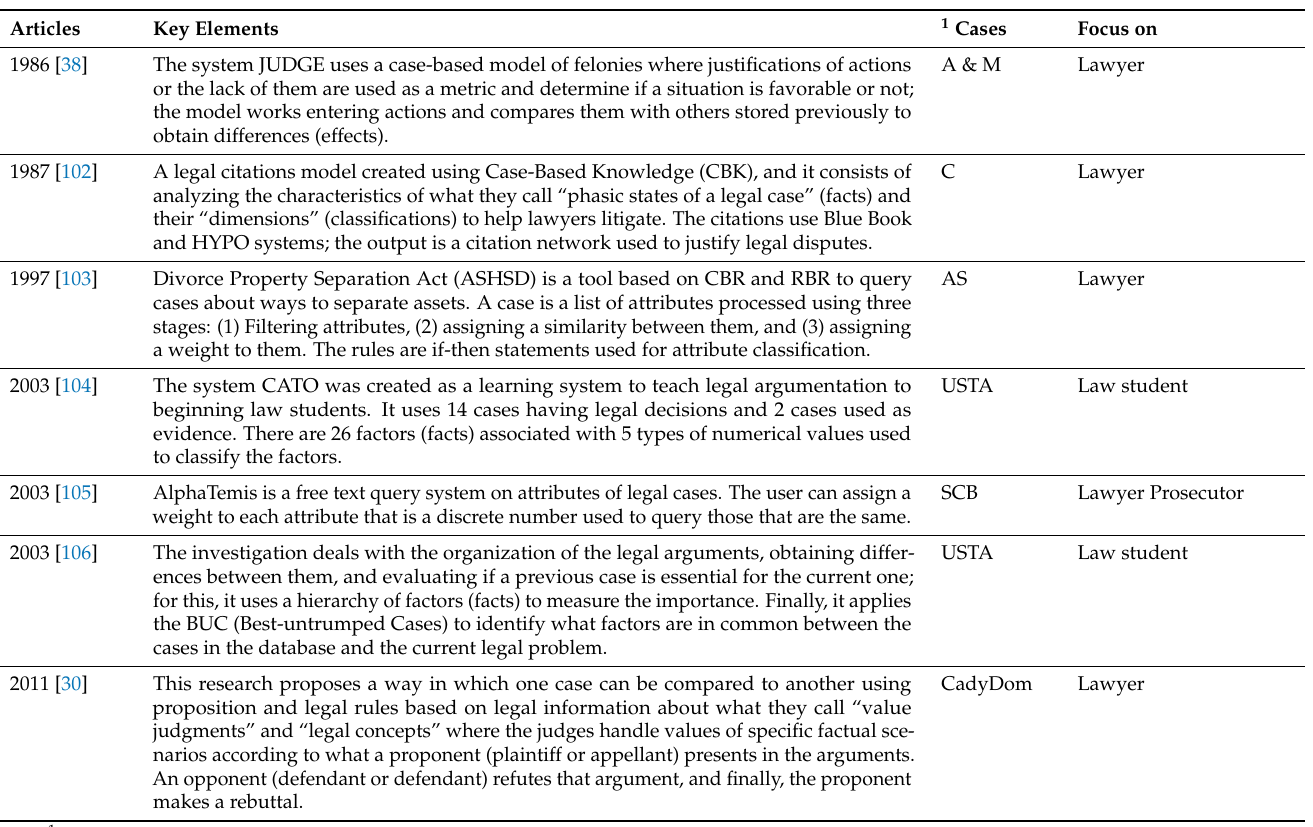
Figure A1. Representation of a case structure with ordered pairs ordered triple, and datasets used to process the information obtained graphically from images in the KG. The vectors are extracted through these structures and used in similarity functions in component 8 from Table A1. Observation : t structure is similar to r , so the details of t are omitted for clarity of the diagram. Table A5. Case-based reasoning related work